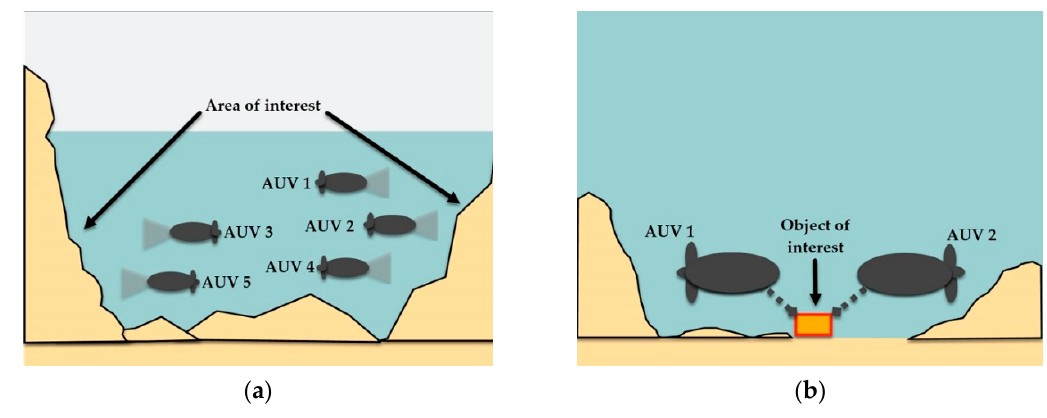
Figure 17. Collaborative missions for AUVs. ( a ) Cooperative inspection of subsea formations. ( b ) Cooperative object recovery.